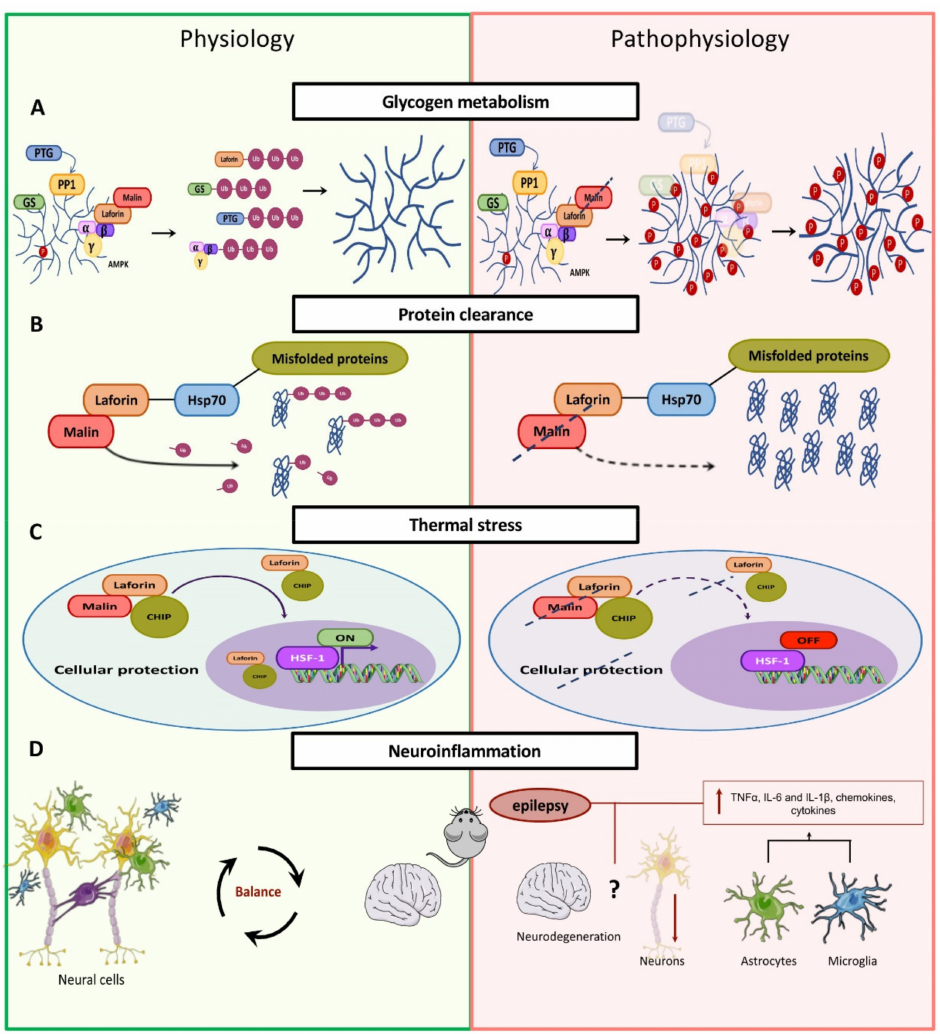
Figure 6. Physiological and pathophysiological processes related to malin. Panel ( A ), physiological negative regulation of glycogen synthesis through the cooperation of laforin and malin. On the right, formation of hyperphosphorylated glycogen as a consequence of the increase in the levels of PTG, GS, and laforin. Panel ( B ), misfolded protein clearance or aggregation depending on the functional synergy between malin and laforin. Panel ( C ), formation of the ternary laforin–malin–CHIP complex to cope with thermal stress through the transcriptional activation of HSF1. Panel ( D ), mouse animal models for LD show the reduced viability of neurons and elevated levels of pro-inflammatory mediators triggered by astrocytes and